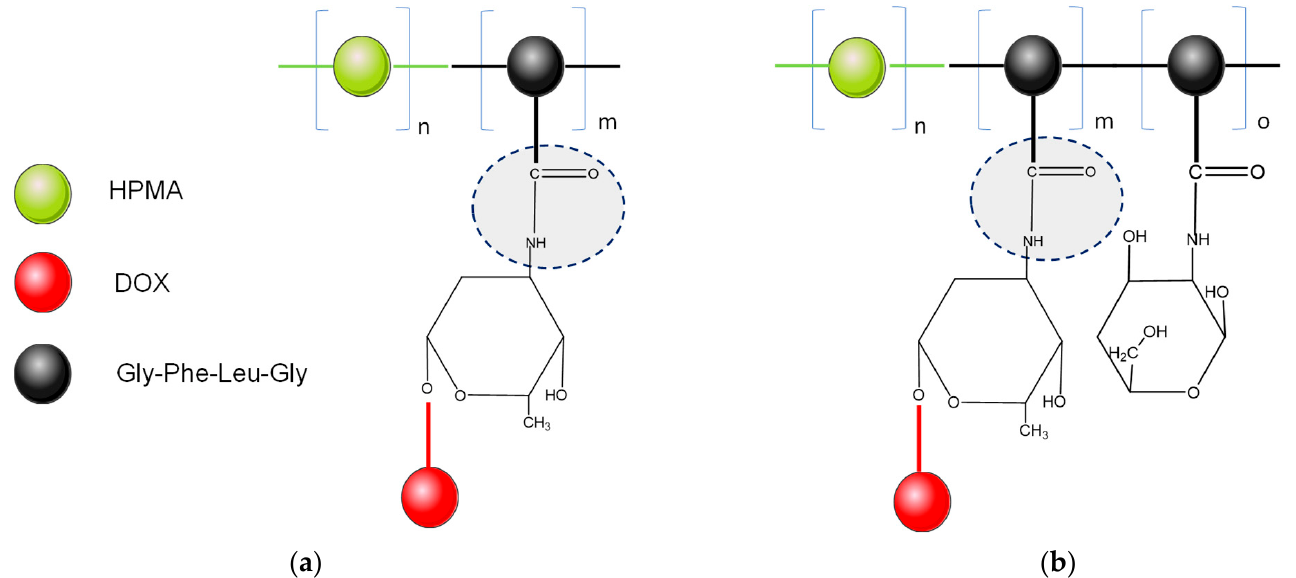
Figure 3. Examples of doxorubicin and HPMA conjugates: ( a ) PK1; ( b ) PK2. Adapted from [35], published by RSC, 2019. DOX—doxorubicin; Gly-Phe-Leu-Gly—glycine–phenylalanine–leucine- glycine linker; HPMA—hydroxypropyl methacrylate.